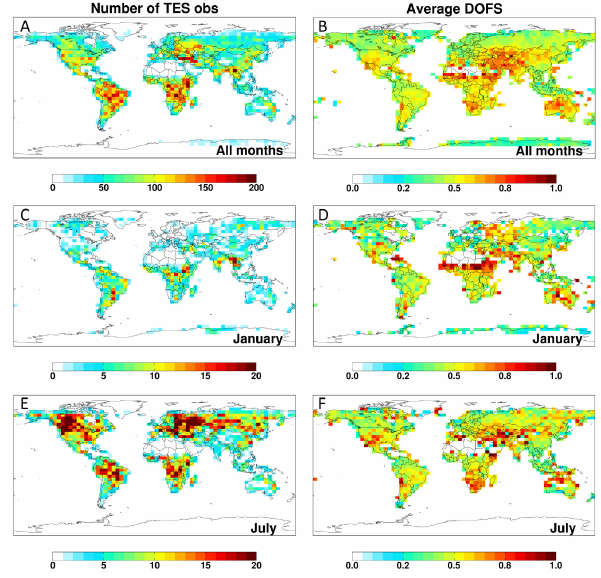
Fig. 1. TES sampling frequency and degrees of freedom for signal (DOFS) for methanol. Shown are the number of TES methanol ob- servations in each 4 ◦ × 5 ◦ GEOS-Chem grid box, and the average DOFS for those observations, during (A) – (B) all months of 2008– 2009; (C) – (D) January 2008 and 2009; and (E) – (F) July 2008 and